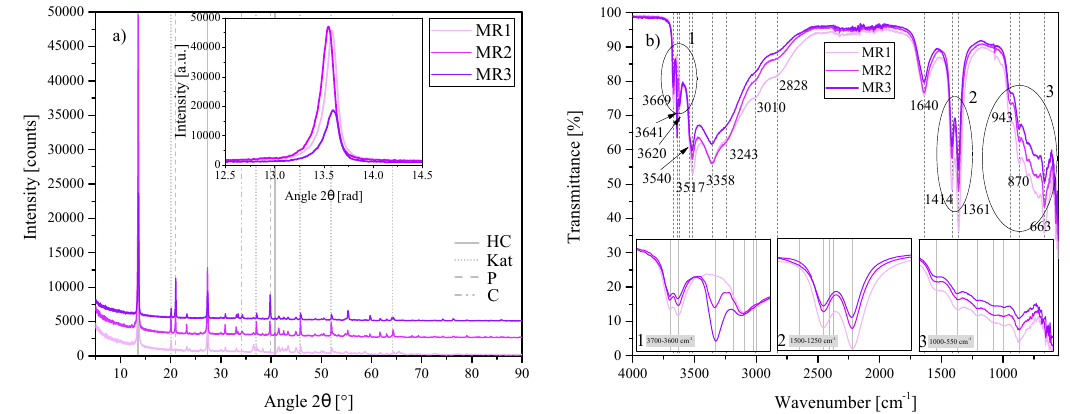
Figure 11. ( a ) XRD results of the molar calcium-to-aluminium ratio series MR1, MR2 and MR3 between 5 ◦ 2 θ and 90 ◦ 2 θ . Each scan is y-shifted by 2500 counts. The inset depicts the primary LDH peaks and change in position. HC = hydrocalumite, Kat = katoite, P = portlandite and C = calcite. ( b ) FTIR-ATR scans of the molar calcium-to-aluminium ratio series MR1, MR2 and MR3 between 4000cm − 1 and 550cm − 1 . The three insets show the regions: ( 1 ) 3700cm − 1 – 3600cm − 1 , ( 2 ) 1500cm − 1 – 1250cm − 1 , ( 3 ) 1000cm − 1 – 550cm − 1 in detail. Dashed and solid grey lines indicate the maxima of vibrations. MR1 = 3:2, MR2 = 4:2 and MR3 = 6:2.